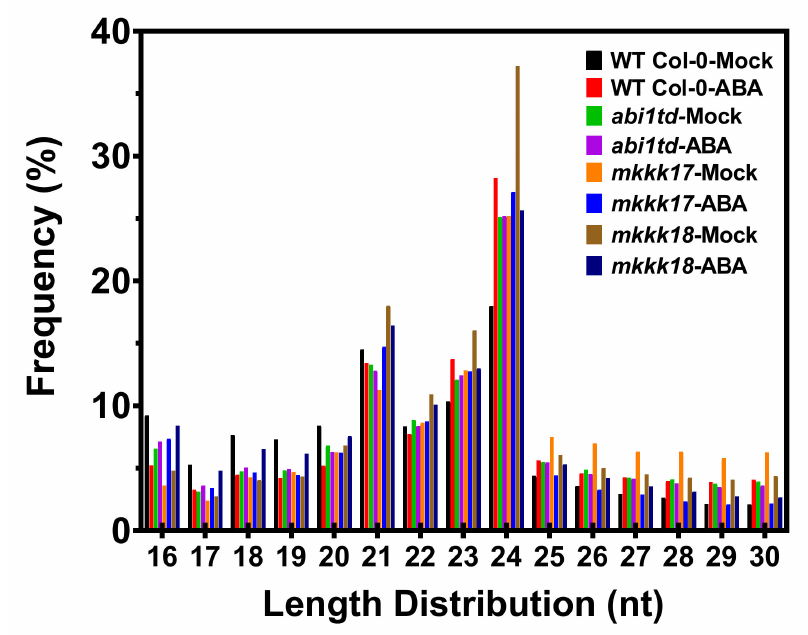
Figure 1. Length distribution of small RNAs. Length distribution of small RNAs in samples of Arabidopsis WT Col-0, abi1td , mkkk17 , and mkkk18 mutants before or after four hours of 100 µ M ABA treatment (mock- and 100 µ M ABA-treated). The X-axis represents the small RNA length (nucleotides) and the Y-axis represents the percentage of small RNA